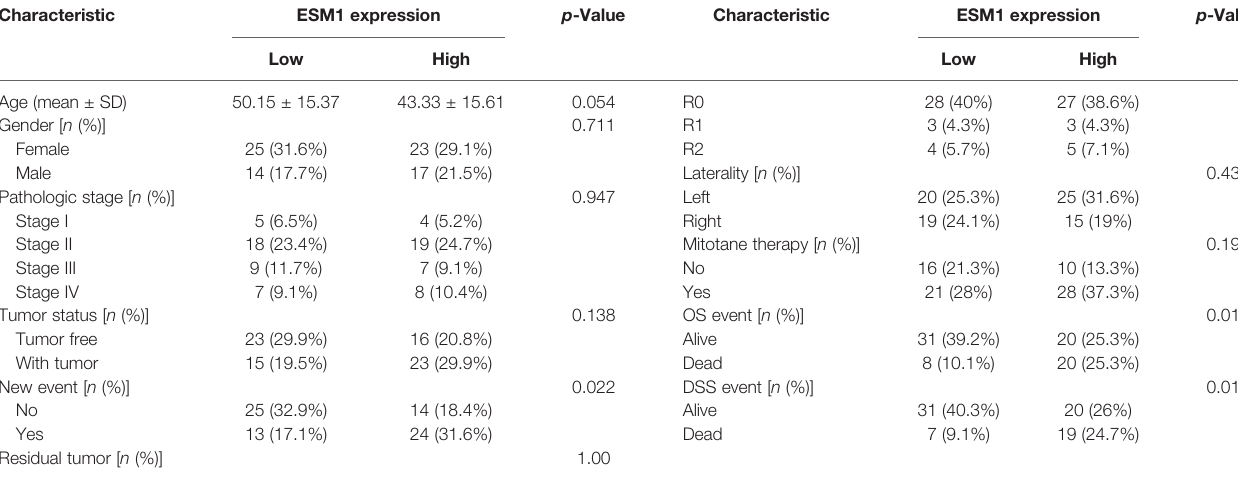
TABLE 1 | Correlation between ESM1 expression and clinicopathological